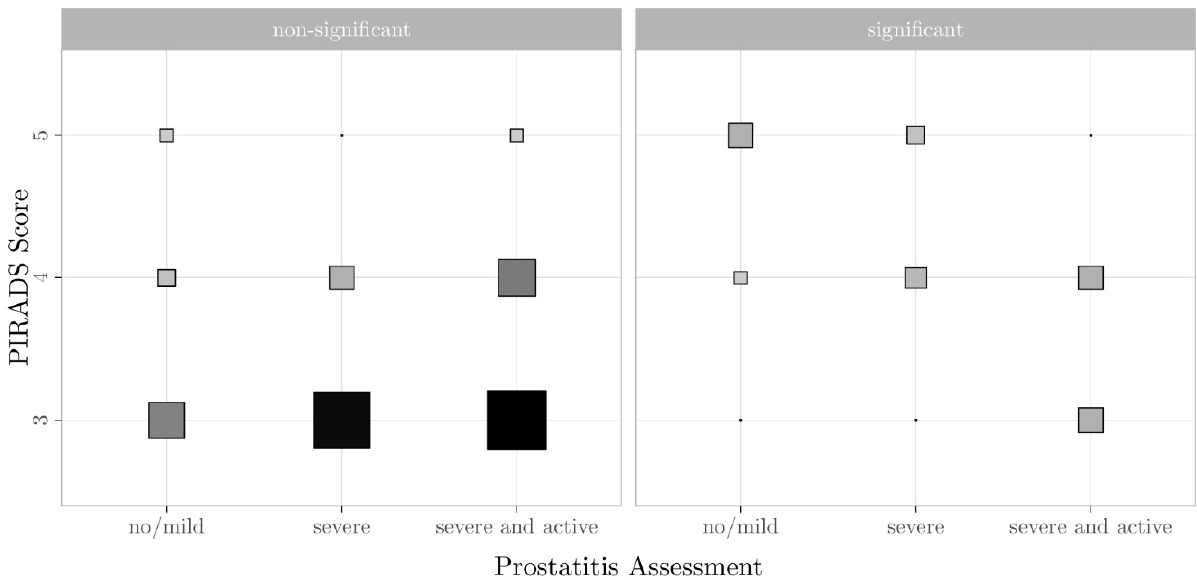
Figure 6. The relationship between the PI-RADS scores, the presence of clinically significant prostate cancer (csPCa)/non- csPCa, and the prostatitis rating in the peripheral zone (PZ). Particularly in diffuse inflammatory active prostatitis, PI-RADS 3 scores corresponded to non-csPCa in the majority of cases. The underlying data are shown in Table 3. Table 2. Absolute values for the association between the PI-RADS scores and prostatitis grade in the peripheral zone with totals, combining severe prostatitis with and without positive DCE, and disregarding the histopathological results of prostate cancer.